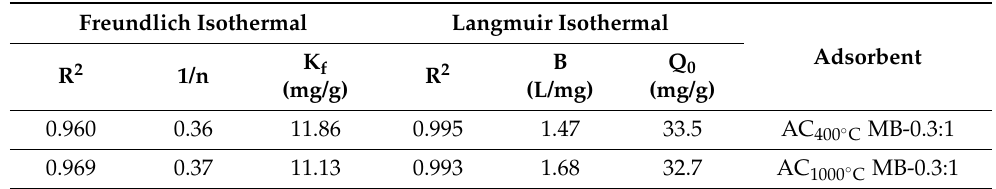
Table 2. Comparison of adsorption isothermal models for adsorbents (AC 400 ◦ C MB-0.3:1 and AC 1000 ◦ C MB-0.3:1).